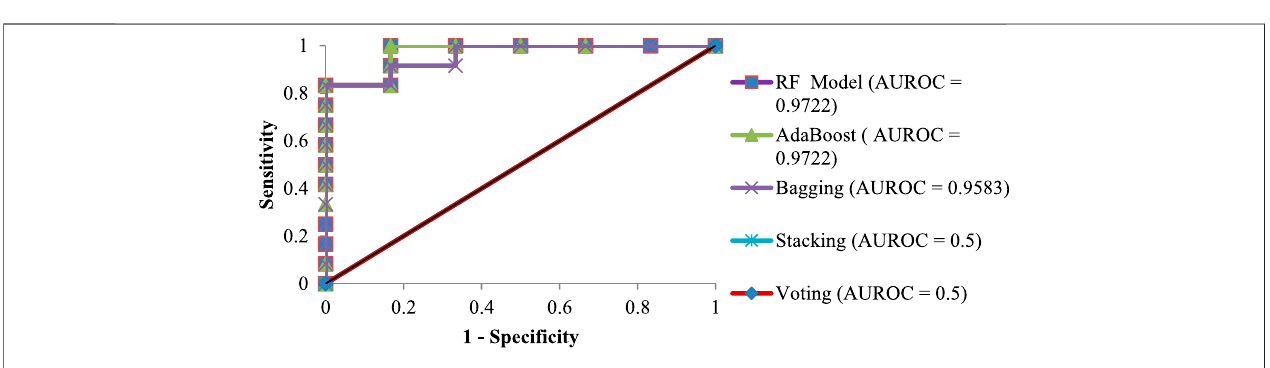
FIGURE 6 | ROC curves for ensemble ML techniques in the test dataset.